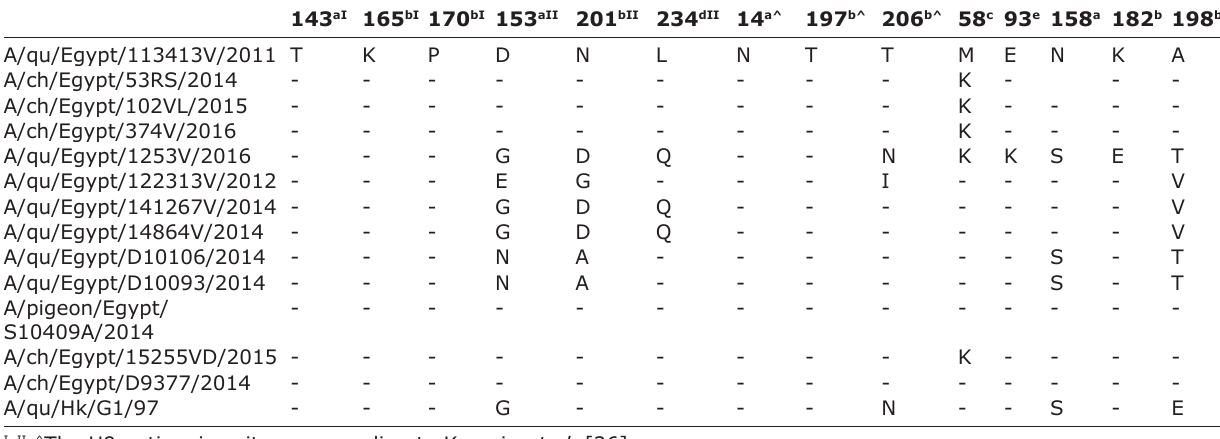
Figure-2: Three-dimensional structures of HA monomer of Egyptian H9N2 avian influenza virus created by PyMOL 1.1 program (DeLano Scientific LLC), the 3D molecular structures of 2 Egyptian isolates show the differences in the antigenic sites on the globular head of the mature HA monomer, (a) the molecular structure of HA protein of A/ quail/Egypt/1253V/2016 and (b) the molecular structure HA protein of A/chicken/Egypt/374V/2016. Each amino acid residue labeled with different Table-3: Amino acid mutations in HA antigenic epitopes of Egyptian H9N2 viruses.